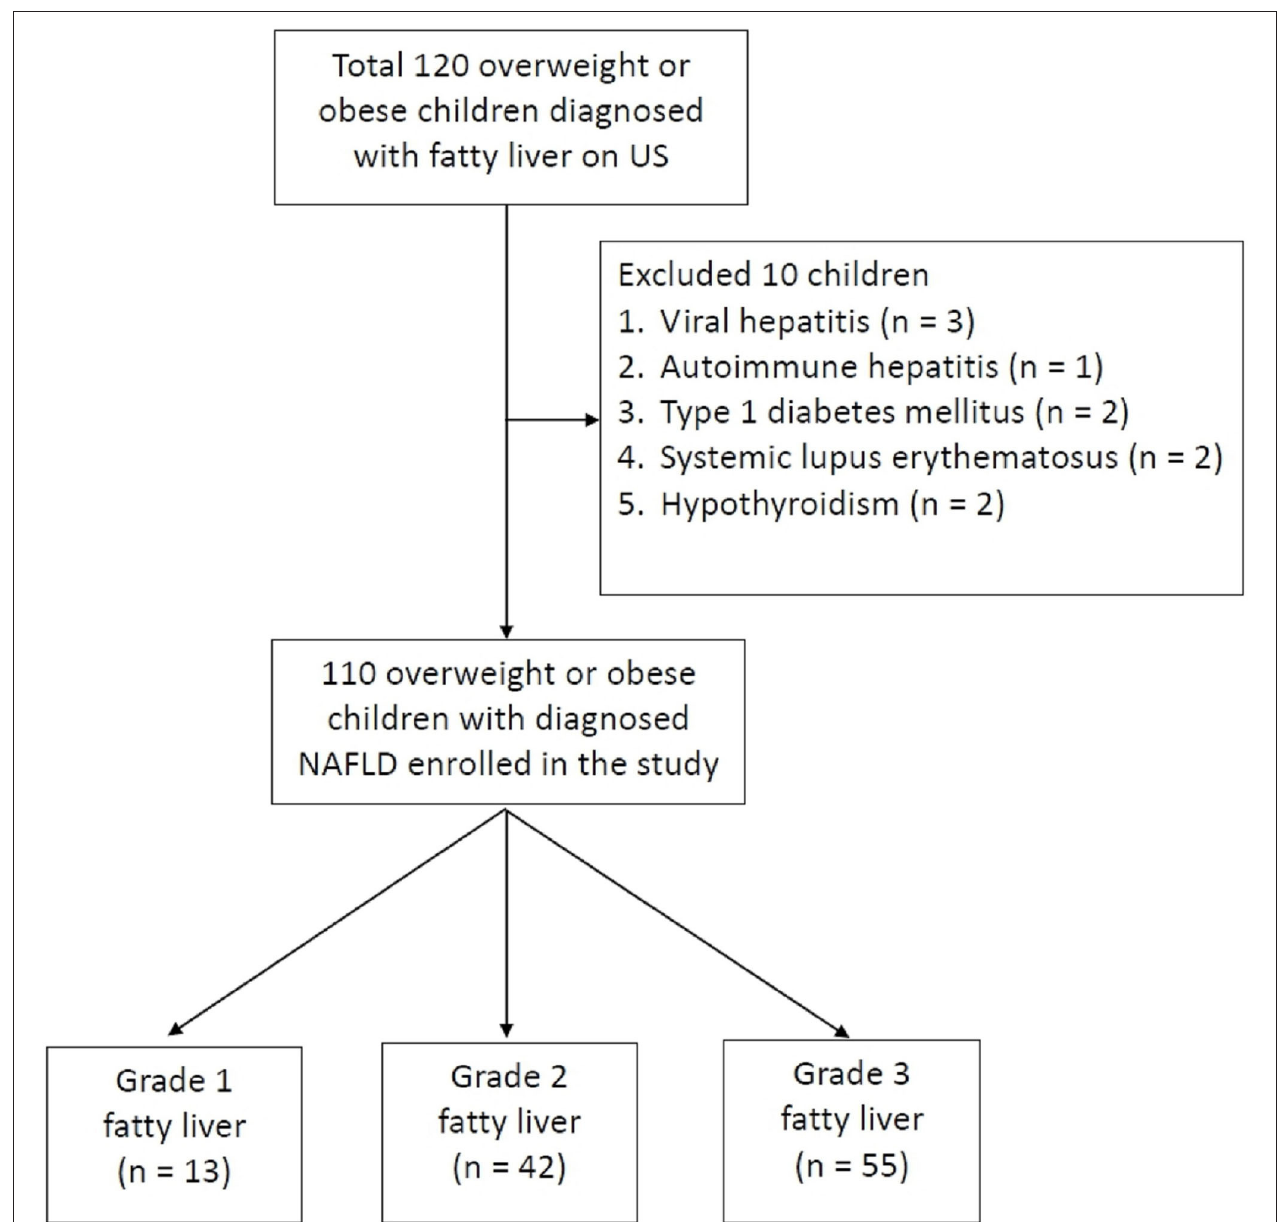
FIGURE 2 | Flow chart shows patient inclusion, exclusion criteria, and classification. A total of 120 met the inclusion criteria; 10 were excluded for assorted medical conditions, with 110 patients finally being included in the study. The study patients are divided into three groups according to the grading of fatty liver on US.